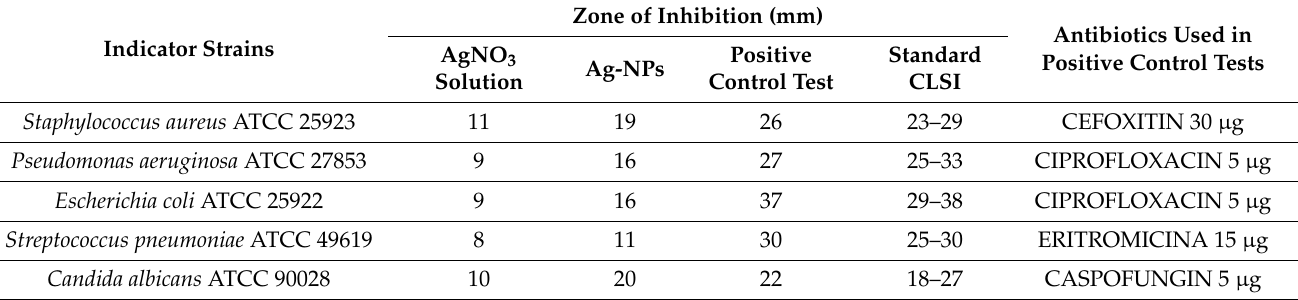
Candida albicans ATCC